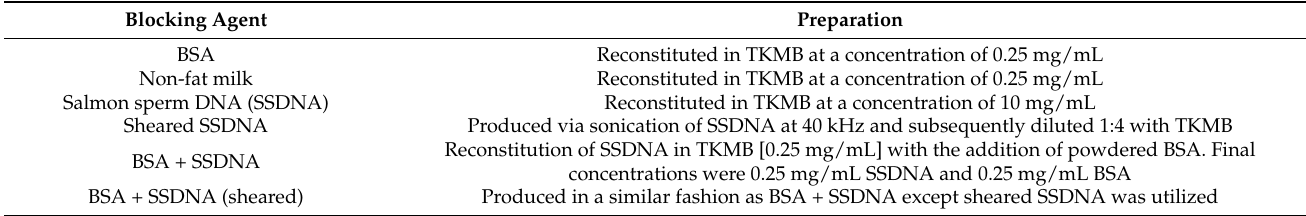
Table 1. Blocking solutions used during the development of the enzyme-amplified electrochemical biosensor.